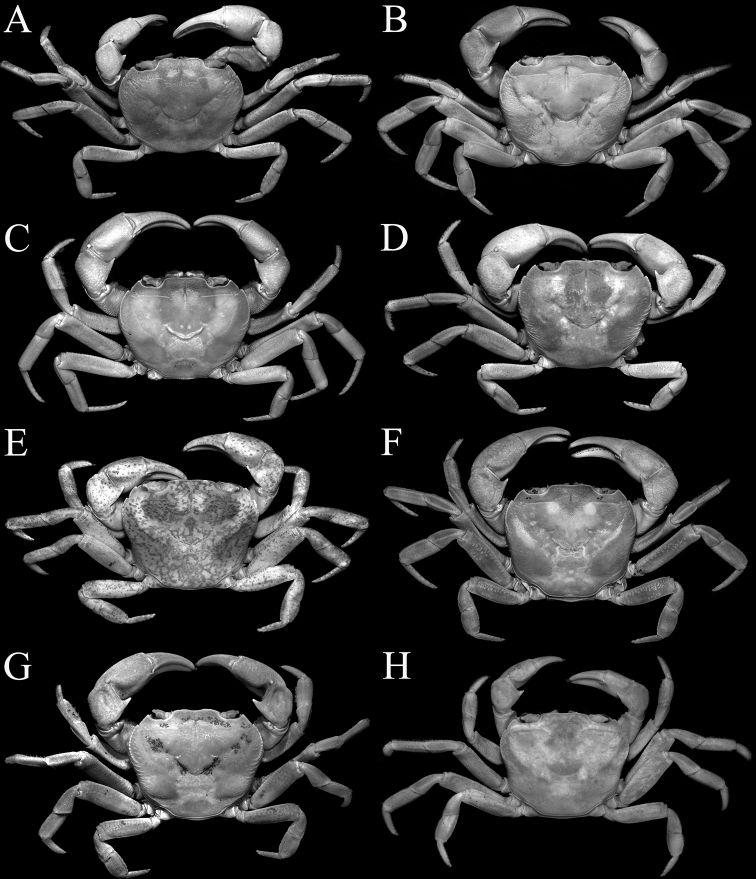
Overall dorsal view AJohora
intermedia Ng, 1986, holotype male (19.8 × 15.1 mm) (ZRC 1984.6529), Pahang BJ.
tahanensis (Bott, 1966), male (30.7 × 25.5 mm) (ZRC 1984.6795), Pahang CJ.
thoi Ng, 1990, holotype male (41.2 × 33.3 mm) (ZRC 1989.2249), Terengganu DJ.
hoiseni Ng & Takeda, 1992, holotype male (25.1 × 21.1 mm) (ZRC 1984.6673), Kelantan EJ.
thaiana Leelawathanagoon, Lheknim & Ng, 2005, paratype male (22.2 × 18.6 mm) (ZRC 2006.0052), Thailand FJ.
booliati sp. nov., holotype male (34.6 × 30.0 mm) (ZRC 2020.0072), Pahang GJ.
erici sp. nov., holotype male (38.3 × 32.0 mm) (ZRC 2020.0360), Perak HJ.
michaeli sp. nov., holotype male (22.7 × 19.2 mm) (ZRC 2010.0047), Terengganu.